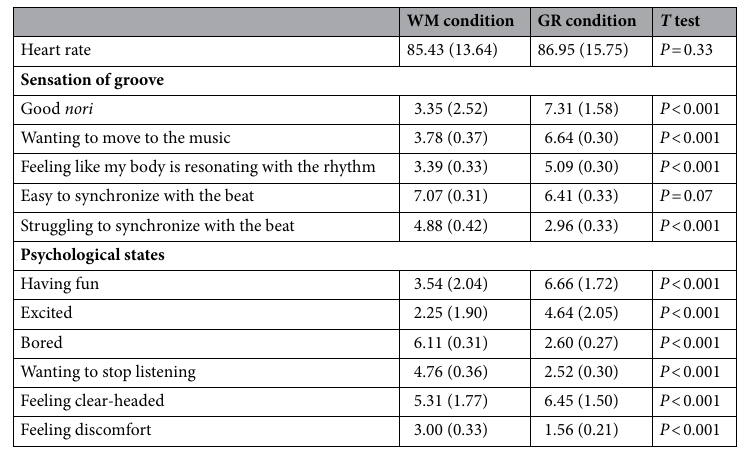
Table 1. Summary of results for physical load and psychological measures for all participants. Data are presented as mean